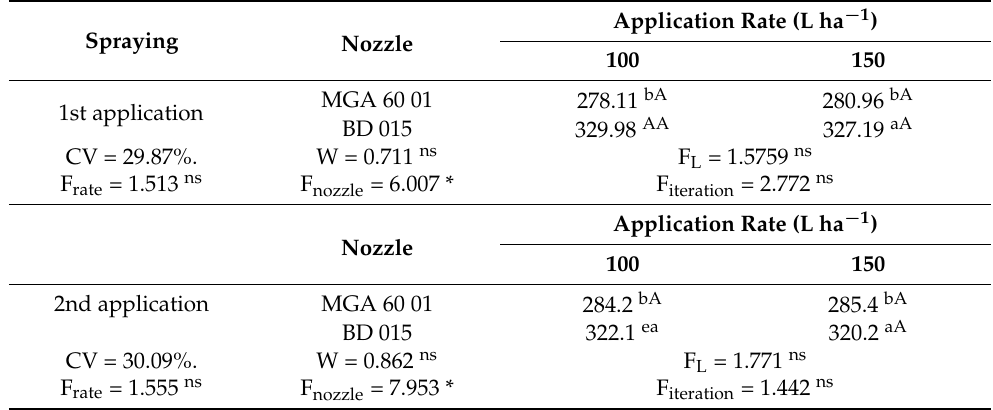
Table 3. Average values of the volumetric median diameter of drops deposited ( µ m) on the leaves of coffee seedlings after spraying with the sunscreen on the leaves of conilon coffee seedlings at 7th (1st) and 30th (2nd) days after planting in pots in the